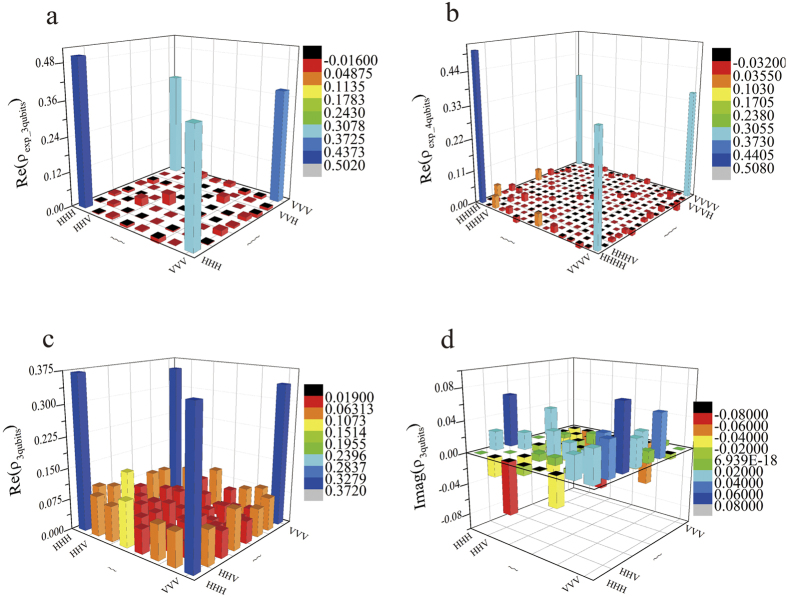
Density matrices (ρexp_3qubits, ρexp_4qubits, ρ3qubits).Different colors are applied to represent the value of elements of density matrices. (a) The real part of experimental density matrix of three-qubit (ρexp_3qubits). (b) The real part of experimental density matrix of four-qubit (ρexp_4qubits). (c) Real part of three-photon density matrix (ρ3qubits) by random creation. (d) Imaginary part of three-photon density matrix (ρ3qubits) by random creation. The error bound for each element of ρexp_3qubits and ρexp_4qubits is no larger than 0.005.